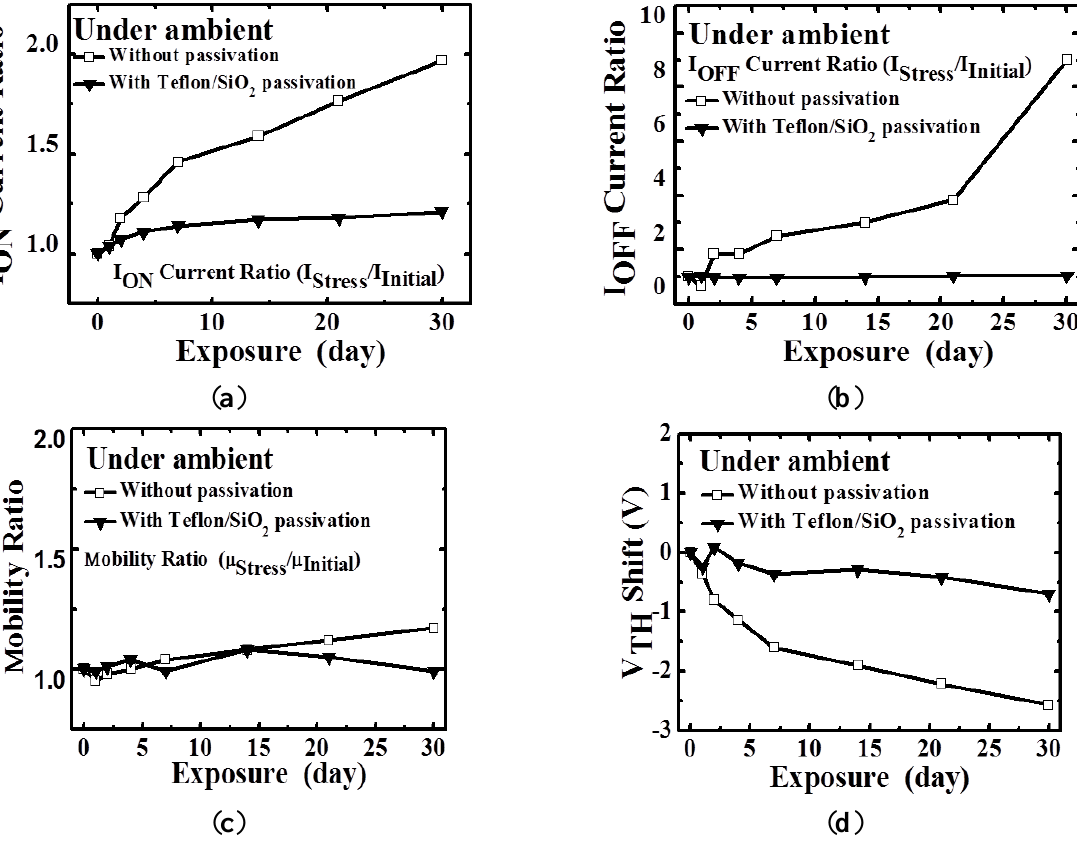
Figure 3. Time-dependent changes in the ( a ) I ON ; ( b ) I OFF ; ( c ) μ FE ; and ( d ) V TH of